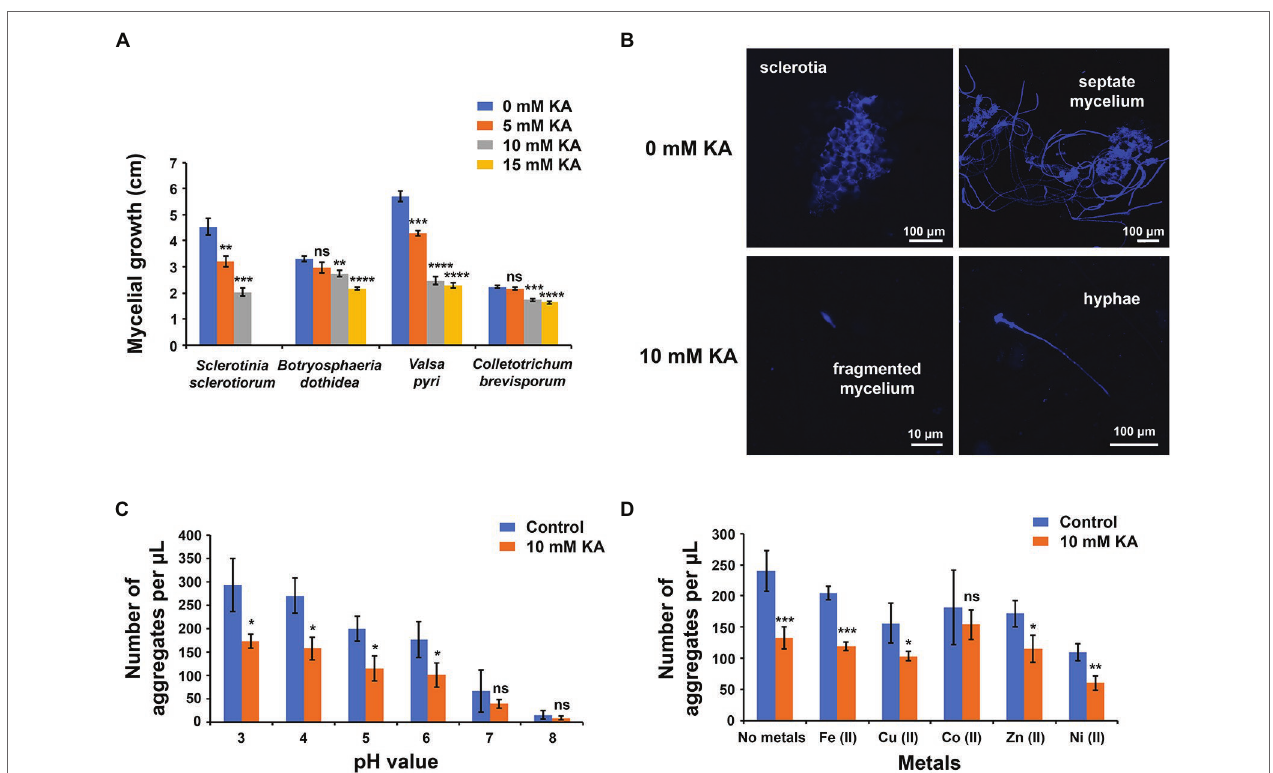
FIGURE 1 | Antifungal properties of kojic acid (KA). (A) Antifungal activity of KA against fungal pathogens Sclerotinia sclerotiorum , Botryosphaeria dothidea , Valsa pyri , and Colletotrichum brevisporum . The antifungal activity was measured according to the inhibition of mycelial growth (each treatment mean represents the average of five repetitions). (B) Fluorescent microscope observations of S. sclerotiorum growth with and without KA treatment (10 mM; 1.42 mg/ml). (C) Effect of pH on the antifungal activity of 10 mM KA against S. sclerotiorum (each treatment mean represents the average of three repetitions). (D) Effect of metal ions (1 mM) on the antifungal activity of 10 mM KA against S. sclerotiorum at pH 4 (each treatment mean represents the average of three repetitions). Significance levels at * p < 0.05, ** p < 0.01, *** p < 0.001, **** p < 0.0001, and no significance (ns). Bars represent the